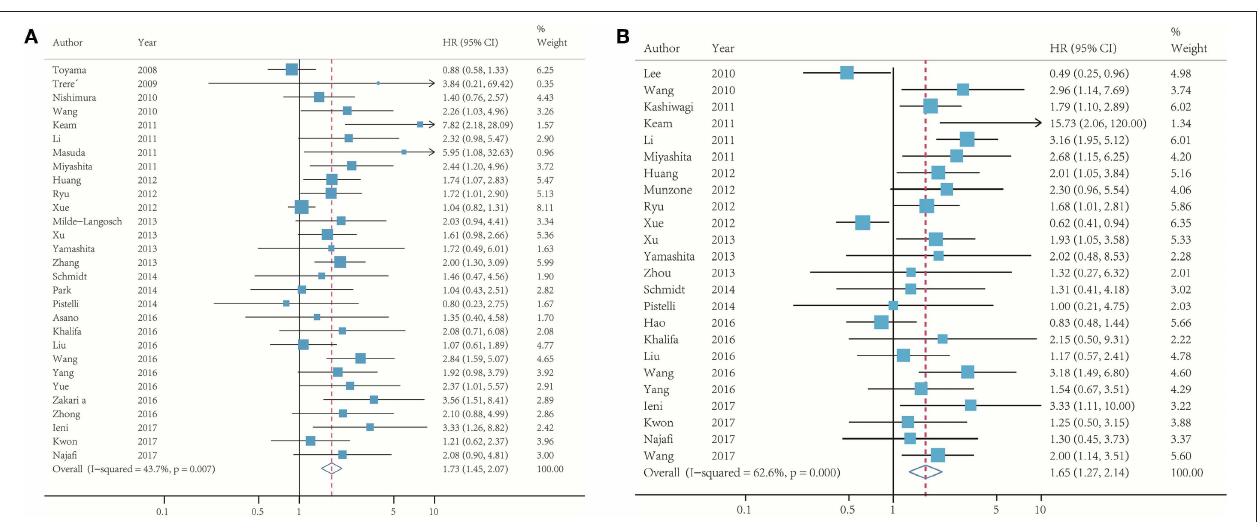
FIGURE 2 | Meta-analysis of the association between Ki-67 and DFS (A) and OS (B)